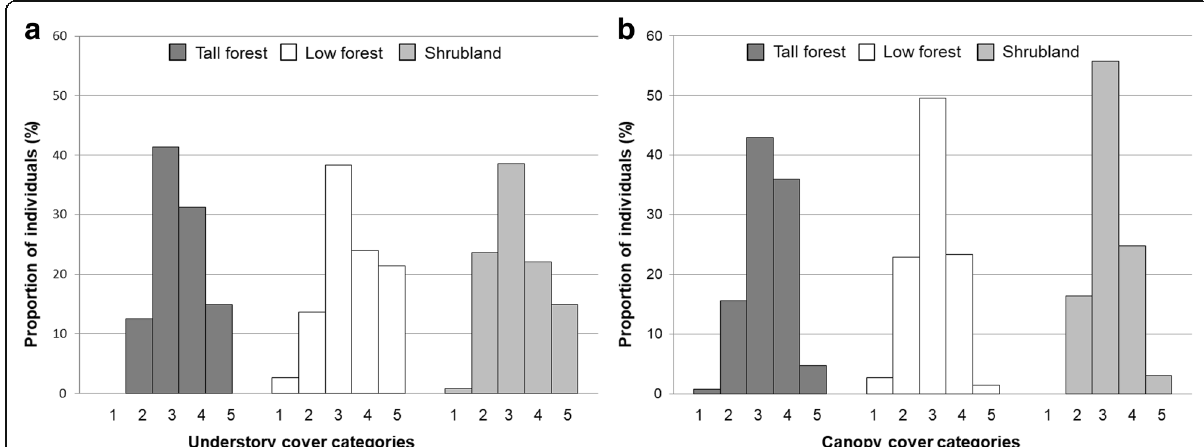
Fig. 7 Proportion of individuals for understory cover and canopy cover categories. a Proportion of individuals in each understory cover category (1 to 5, sparse to dense), by vegetation types. b Proportion of individuals in each canopy cover category (1 to 5, clear to dense), by vegetation